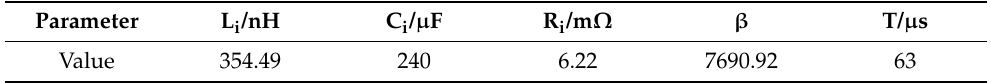
Table 1. Related electrical